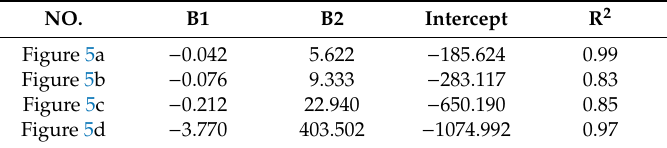
Table 4. Fitted parameters of regression equation. Figure 5. Correlation between porosity and compressive strength. ( a ) 600 kg/cm 3 foamed concrete; ( b ) 700 kg/cm 3 foamed concrete; ( c ) 800 kg/cm 3 foamed concrete; ( d ) 900 kg/cm 3 foamed concrete.